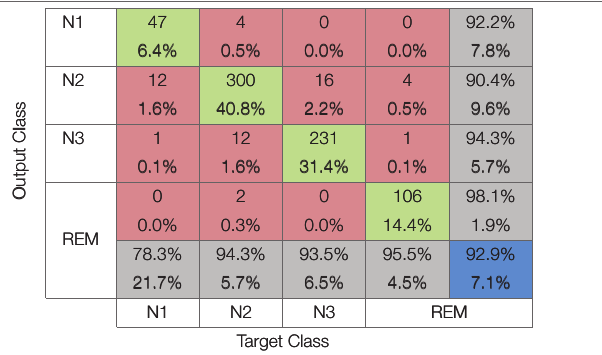
TABLE 4 | Confusion matrix for the Gaussian kernel SVM classifier ( σ achieved maximum accuracy with relative wavelet entropy